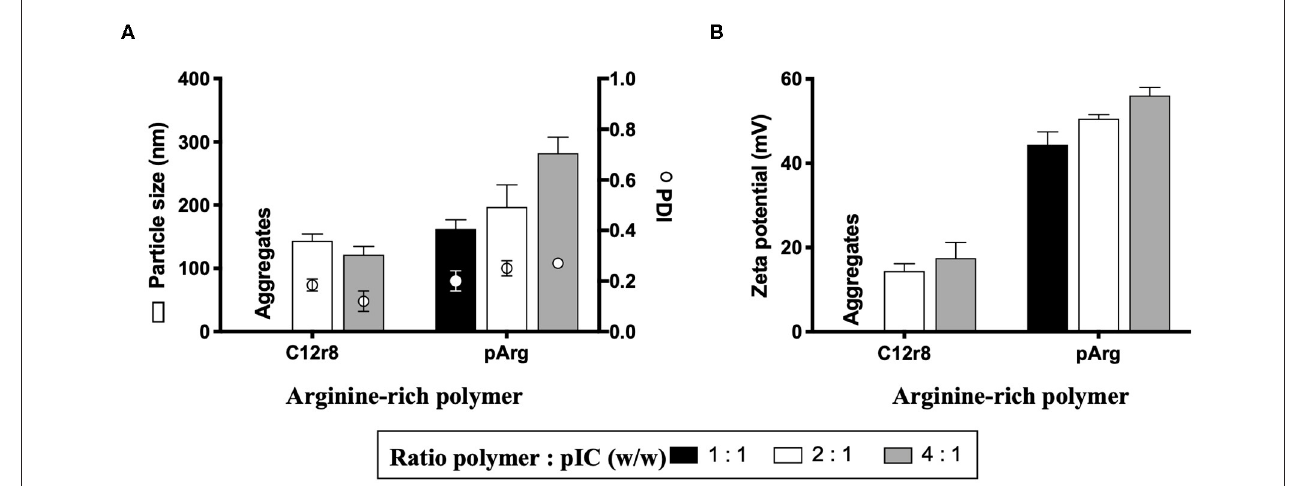
FIGURE 1 | Screening of different arginine-rich polymers to form nanocomplexes with poly(I:C). Values of (A) particle size, PDI and (B) zeta potential of the nanocomplexes obtained for the different ratios tested. Values represent mean ± SD ( n ≥ 3). C12r8, laurate-octaarginine; pArg, polyarginine; PDI, polydispersity index; pIC, poly(I:C); w/w,